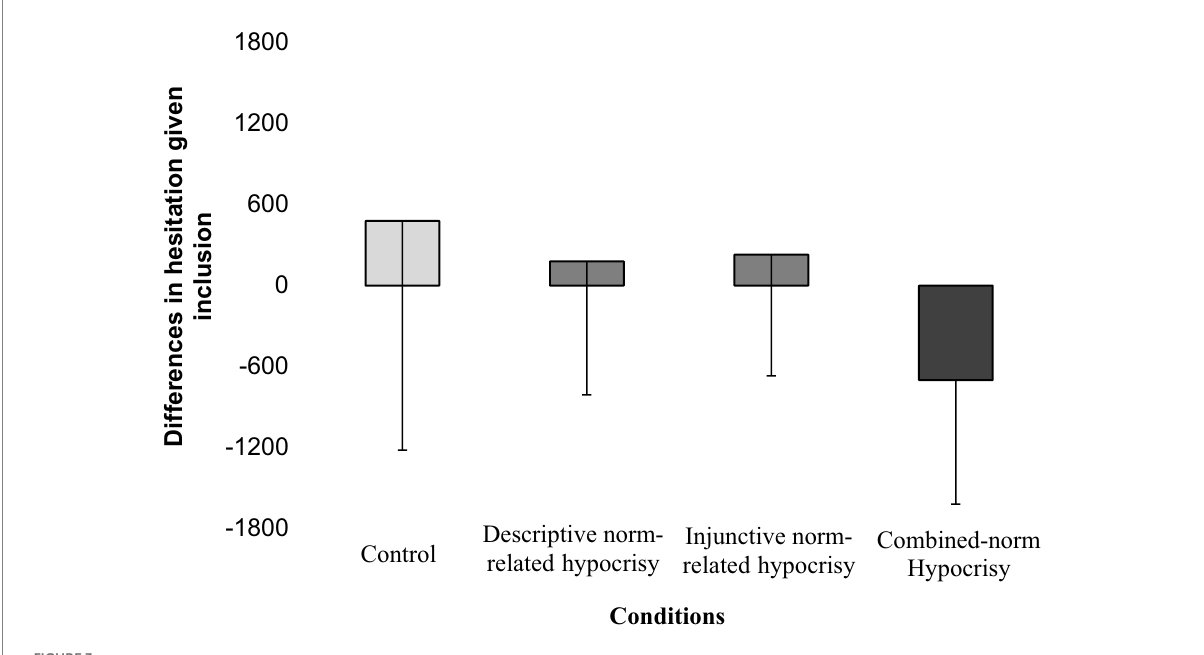
FIGURE 3 Differences in participants’ hesitation given inclusion. Differences in participants’ hesitation given inclusion (HGI) between the black player and the white players are shown for the four experimental conditions ( N = 80). Differences in hesitation given inclusion were calculated by subtracting the average HGI scores of the white players from the HGI score of the black player. Scores are in milliseconds and error bars show standard